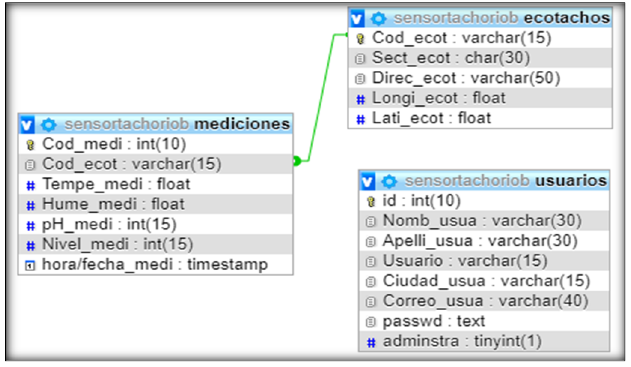
Figure 8. Webhost server.